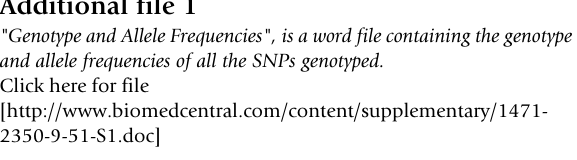
Abbreviations: PCR, Polymerase Chain Reaction; SNP, Single Nucleotide